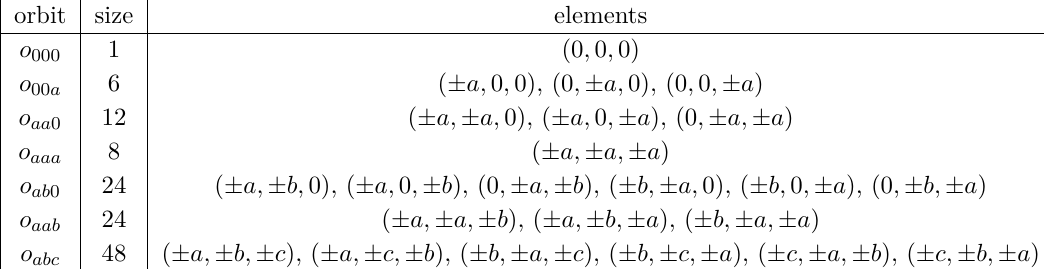
Table 4. Explicit compositions of all types of orbit for the rest frame, d ref = (0 , 0 , 0) . Listed are the forms of the spectator-momentum vectors n = k ( L/ 2 π ) . The integers a, b, c satisfy 0 < a < b < c k but are otherwise arbitrary, and all ± signs are independent of each